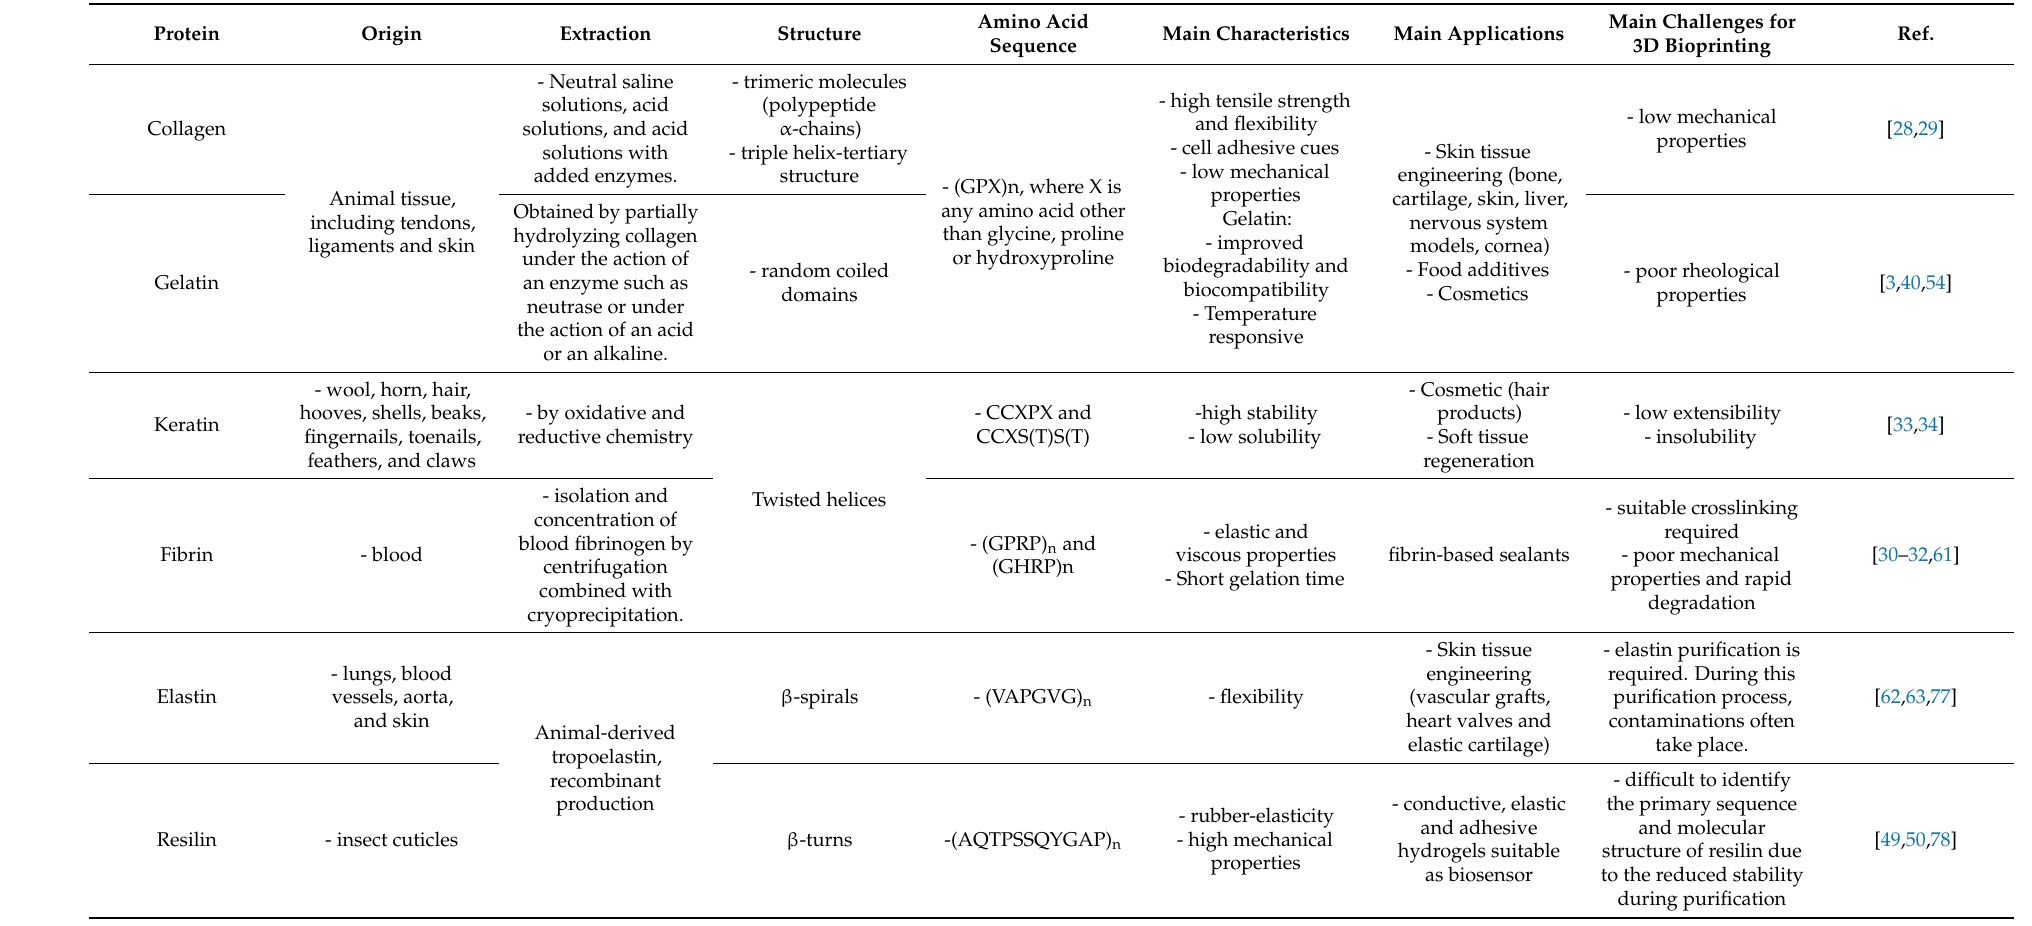
Table 1. Main origin, main characteristics and applications of proteins used in the development of 3D materials and